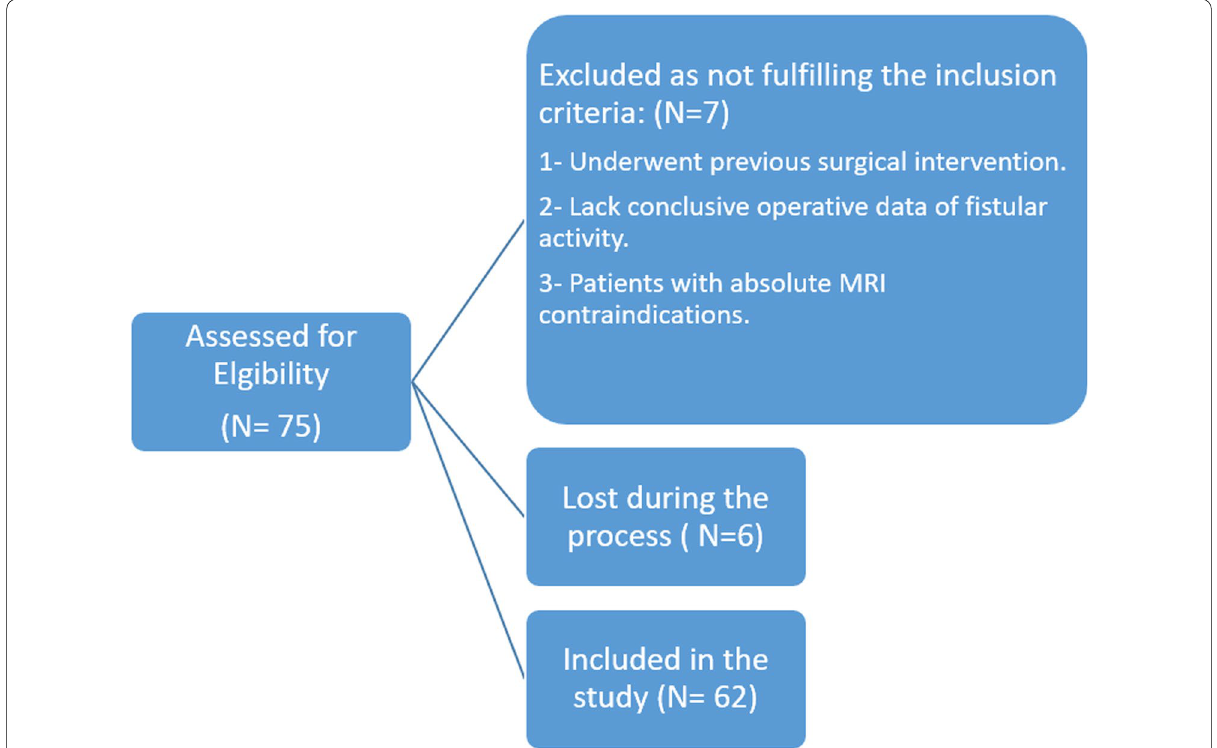
Fig. 1 Flow chart of included